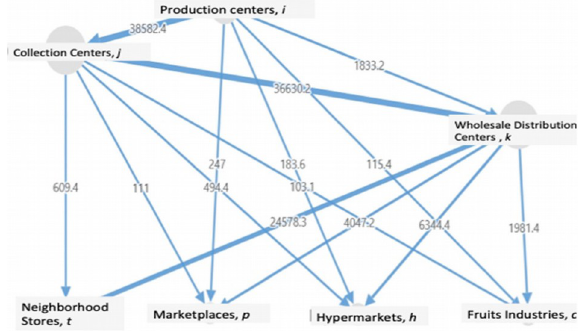
Figure 4. Flows based on objectives, warm climate